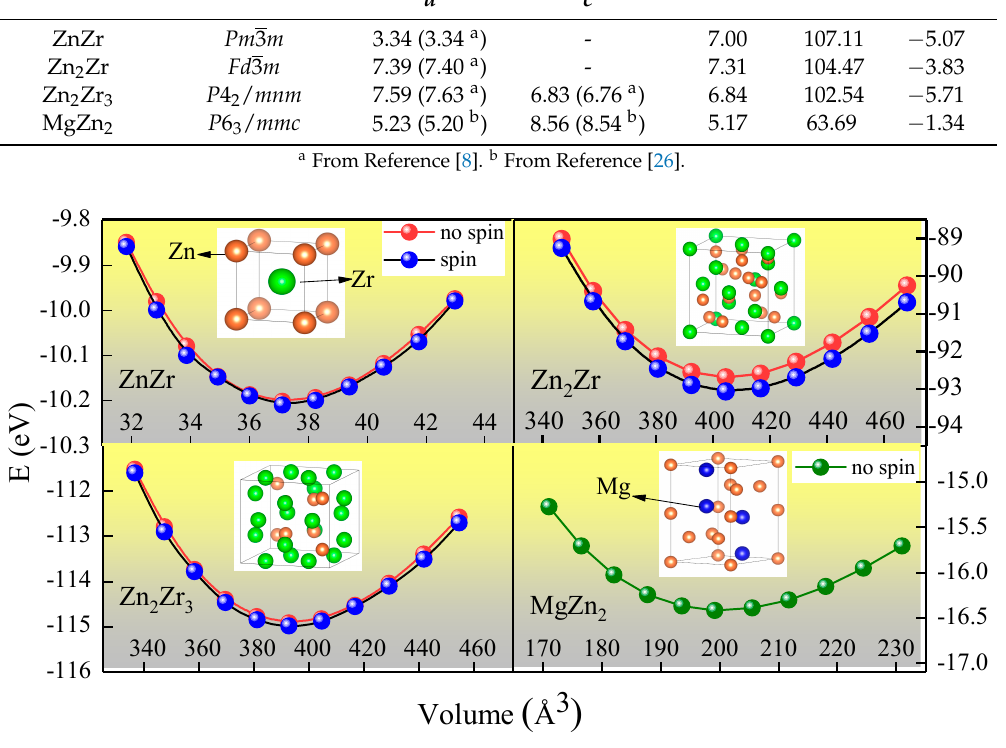
Table 2. The calculated independent elastic constants (GPa) of Zn-Zr intermetallic compounds and MgZn 2 using the strain-energy method with other calculated (Cal.) and experimental (Exp.) data.